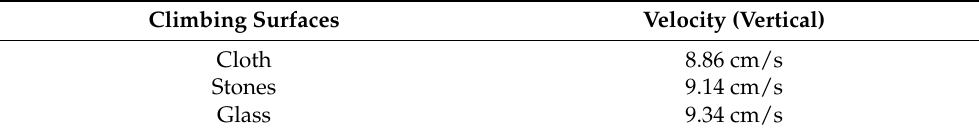
Table 3. The speed of the robot prototype.